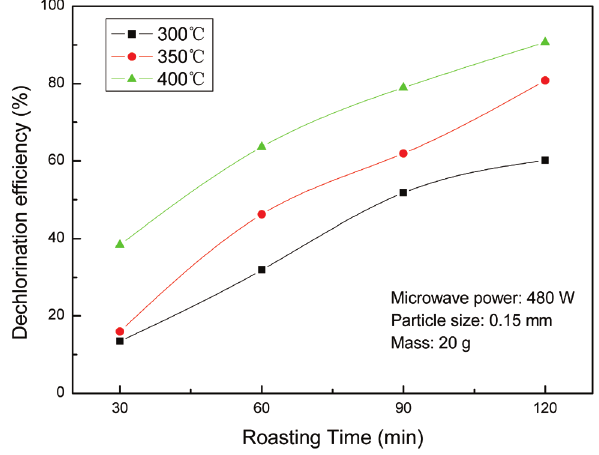
Fig. 4: Effect of time on dechlorination efficiency of Cu